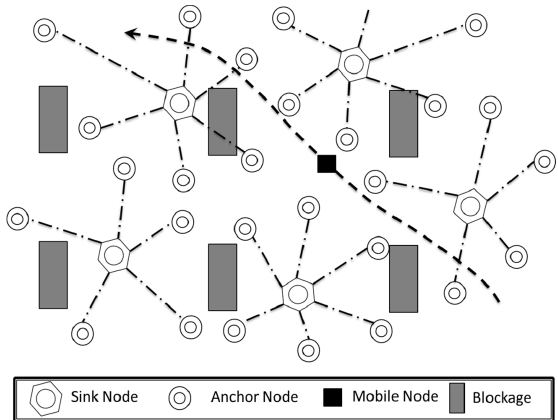
Figure 1. Mobile Node tracking in a factory wireless sensor network (WSN).